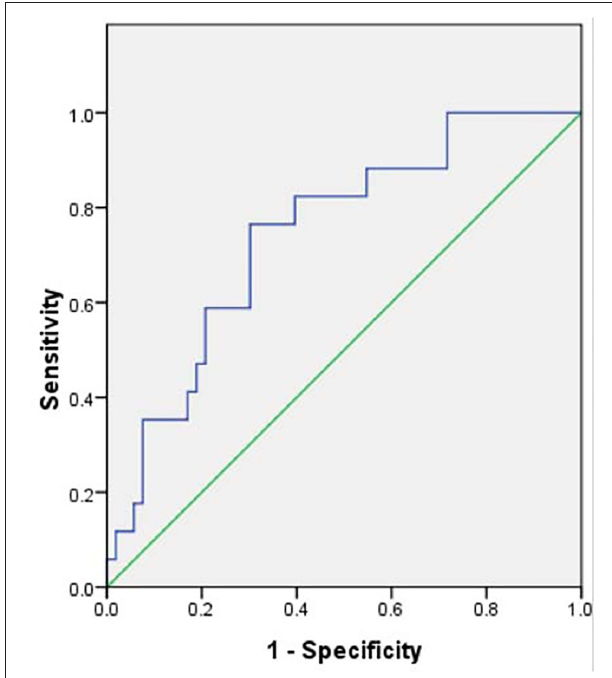
FIGURE 1 | Receiver operating characteristic curve of neutrophil-to-lymphocyte ratio to differentiate circumferential aneurysm wall enhancement, the area under the curve was 0.734. The cutoff value of the neutrophil-to-lymphocyte ratio was 1.86.